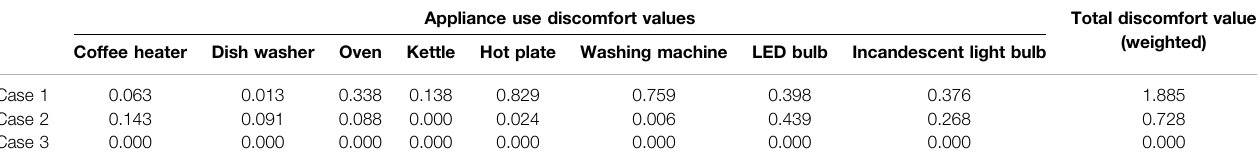
TABLE 4 | Appliance use dissatisfaction